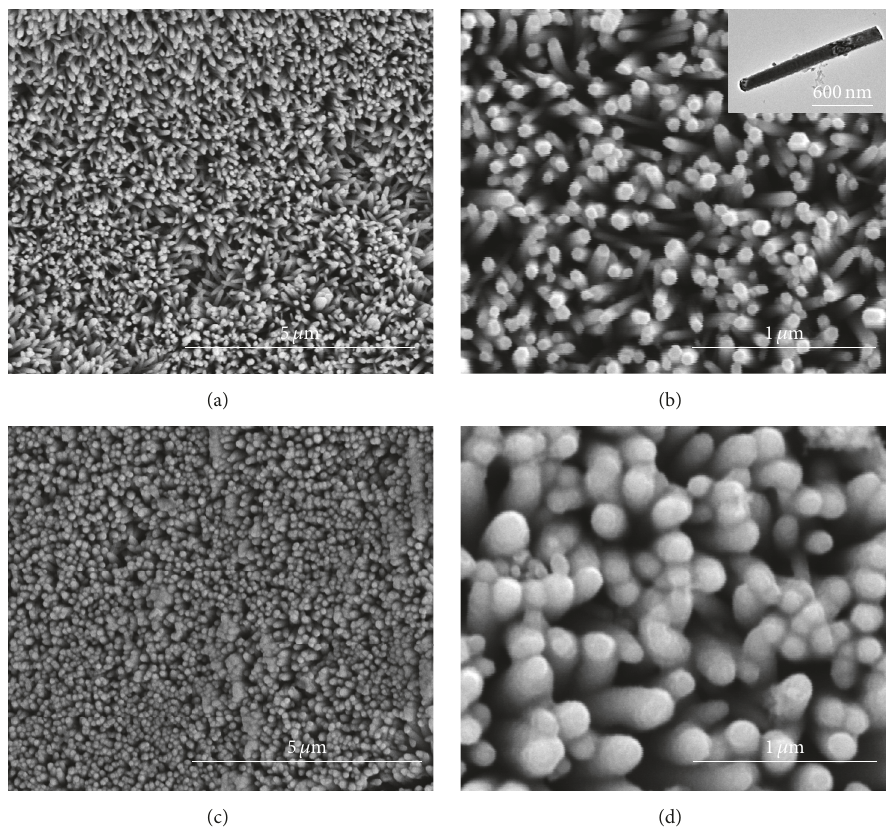
Figure 1: SEM (a) and high resolution SEM (b) of ZnO nanorod arrays (inset of Figure (b): TEM of ZnO nanorod); SEM (c) and high resolution SEM (d) of ZnO@TiO 2 nanorod arrays.